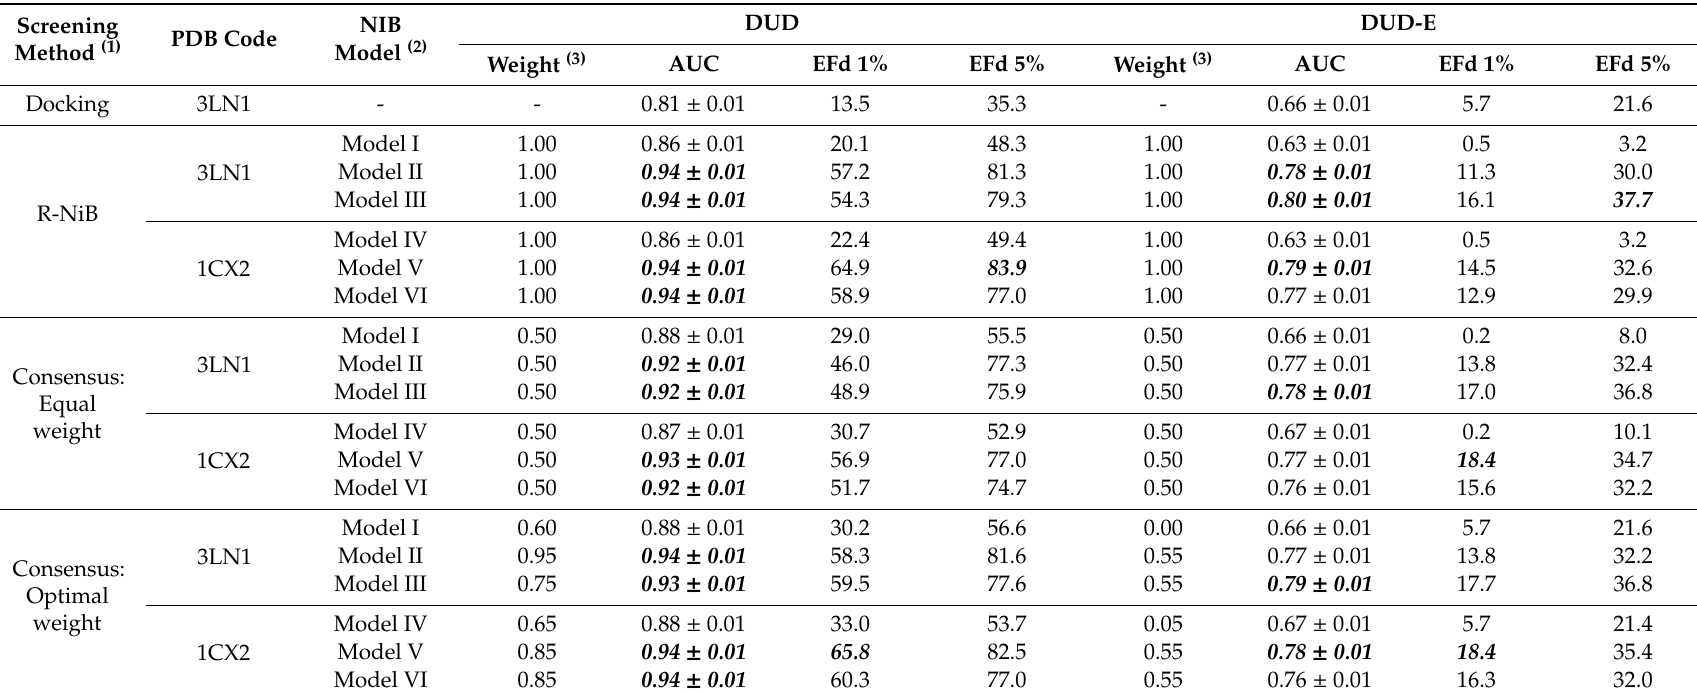
Table 4. Negative image-based rescoring and consensus scoring of docking